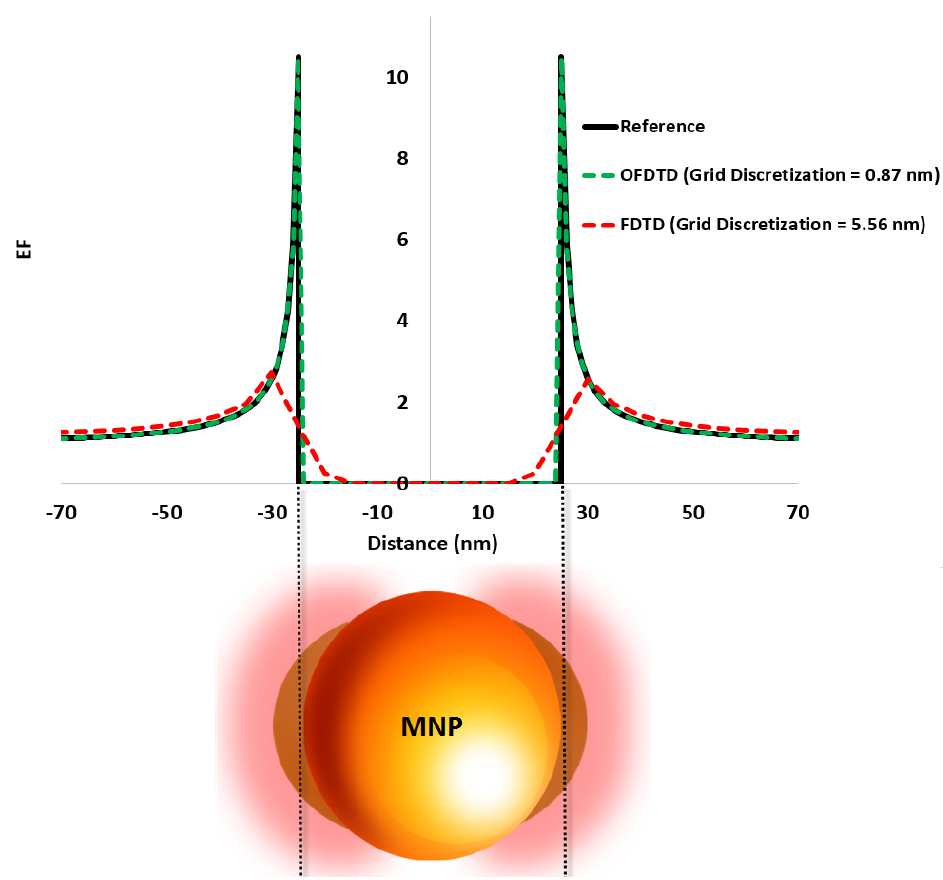
Figure 4. Enhancement factor- comparison of FDTD, OFDTD, and theoretical reference.